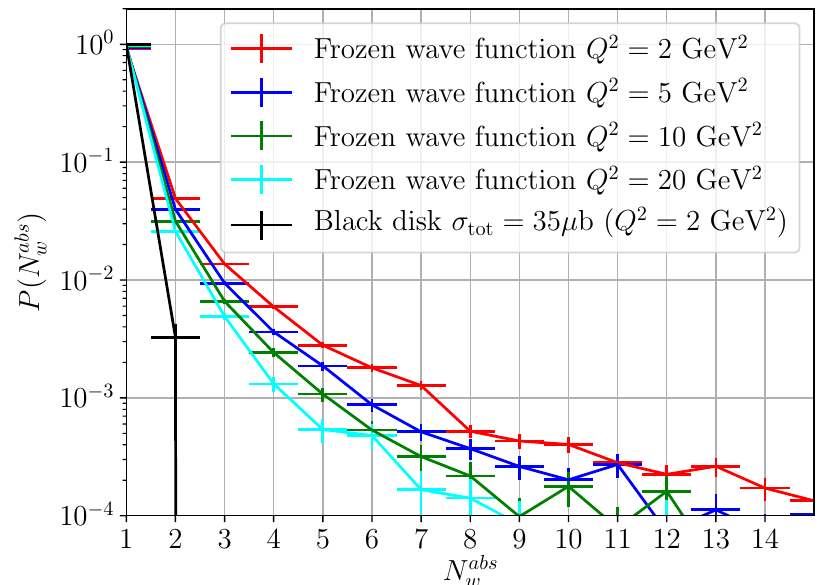
Figure 17. Number of wounded nucleons in a (cid:13) (cid:3) Au collision with W 2 = 5000 GeV 2 and a range of Q 2 , comparing a treatment with the projectile wave function (denoted wf. in legend) frozen throughout the passage of the nucleus, to a naive black disk